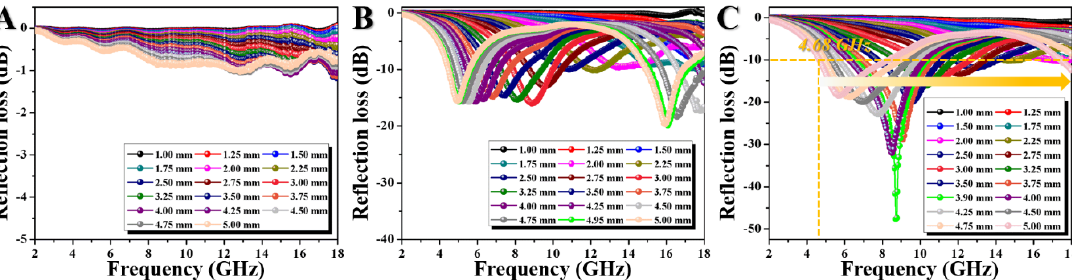
Figure 8. The curves for the responding EMW loss (RL) values of ( A ) MF, ( B ) CMF and ( C ) MCMF.